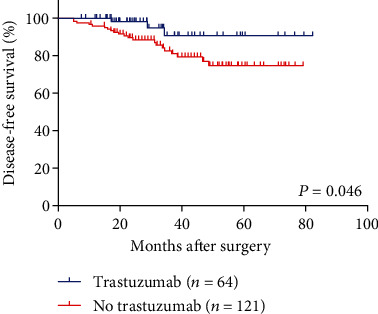
Association of trastuzumab use with DFS in non-pCR patients.